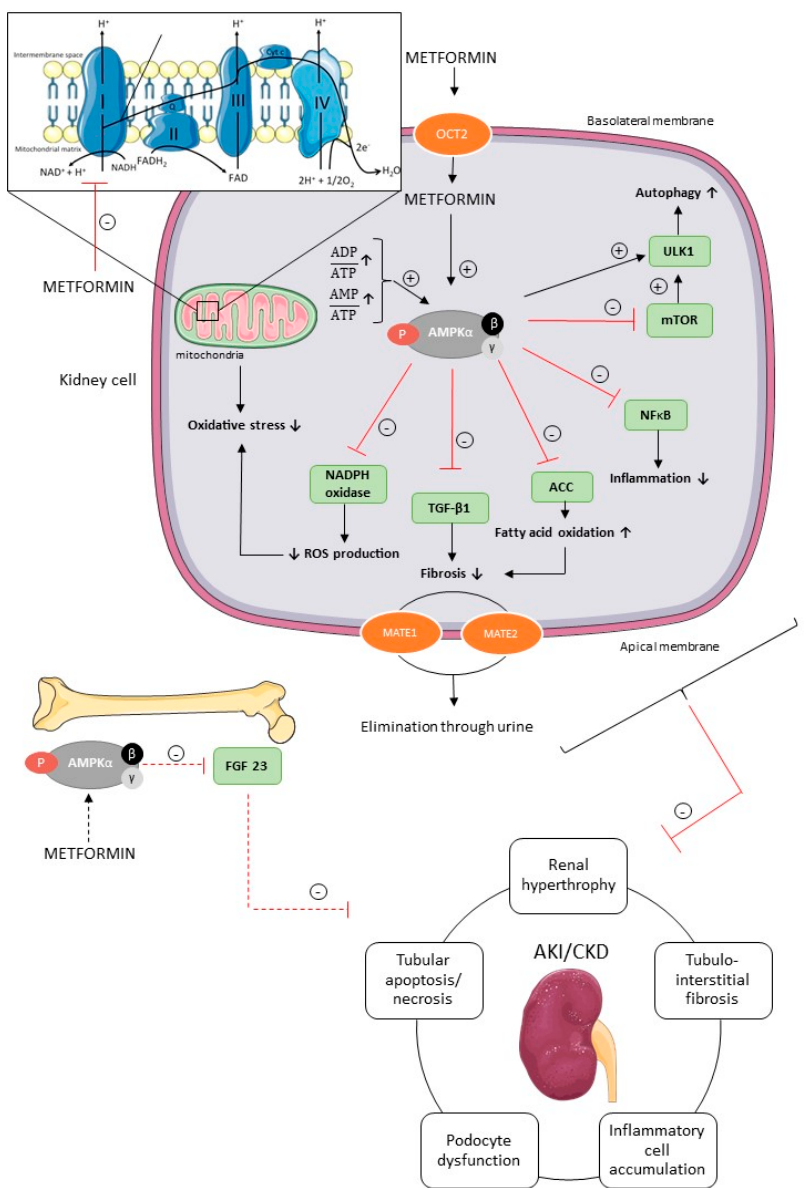
Figure 3. Potential underlying molecular mechanisms of metformin’s renoprotection. Metformin is transported into the renal tubular cells mainly through the plasma membrane transporter OCT2. Inside the renal cell metformin activates AMPK via two separate mechanisms, i.e., the inhibition of the mitochondrial respiratory chain complex 1, and subsequent increase in AMP/ATP and ADP/ATP ratio, and/or the direct activation of AMPK. AMPK has pleiotropic downstream signaling pathways involved in divergent cellular processes, such as autophagy, fatty acid oxidation, inflammation, fibrosis, oxidative stress, and reactive oxygen species (ROS) in renal cells and FGF23 production in bone cells, which have been shown to protect the kidney against AKI and CKD. Further, MATE1 and MATE2 contribute to the renal excretion of metformin. ACC, acetyl-CoA carboxylase; AKI, acute kidney injury; AMPK, AMP-activated protein kinase; CKD, chronic kidney disease; FGF23, fibroblast growth factor 23; MATE1, multidrug and toxin extrusion 1; MATE2, multidrug and toxin extrusion 2; mTOR, mammalian target of rapamycin; NADPH, nicotinamide adenine dinucleotide phosphate; NF κ B, nuclear factor kappa B; OCT2, organic cation transporter 2; ROS, reactive oxygen species; TGF- β 1, transforming growth factor β 1; ULK1, uncoordinated-51 like kinase 1. Figure was produced using Servier Medical Art: https://smart.servier.com/ (accessed on 2 November